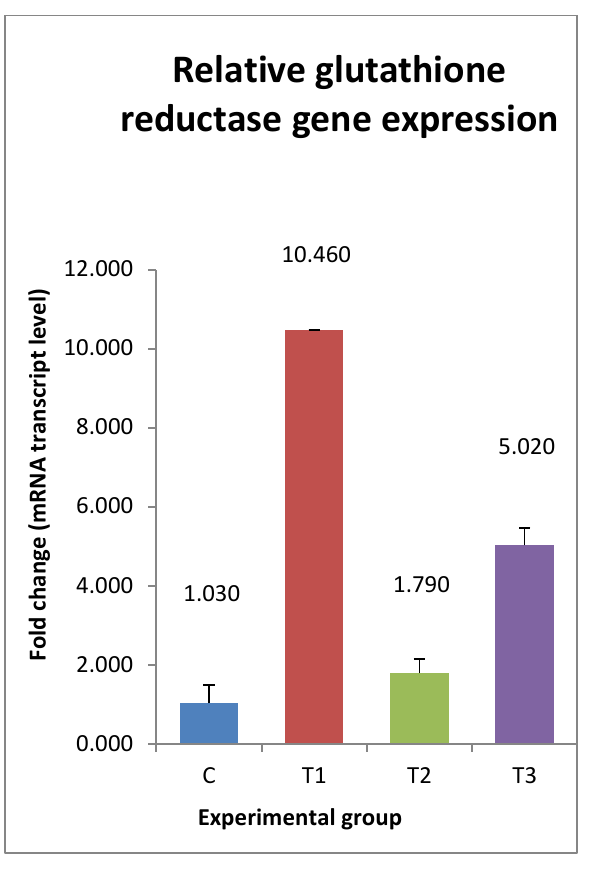
Figure, 2: Effect of alpha lipoic acid or 56 days on gene expression of glutathione reductase enzyme in liver tissue of hydrogen peroxide treated male